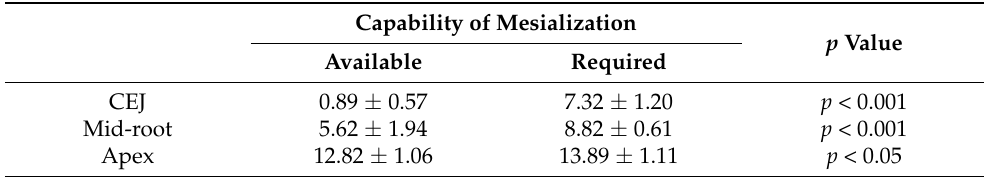
Table 3. Capability of mesialization (mm) in missing group.